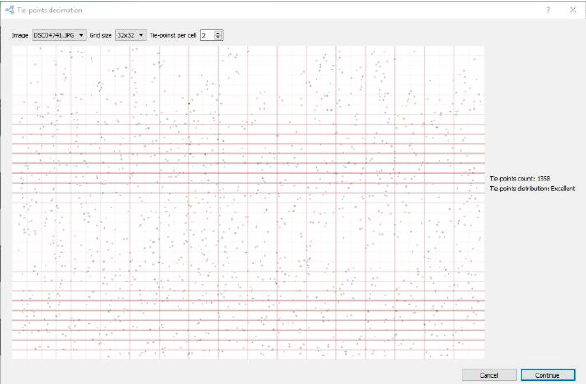
Figure 7. Graphic user interface for the analysis of tie point distribution. Two tie points per cell with a 32x32